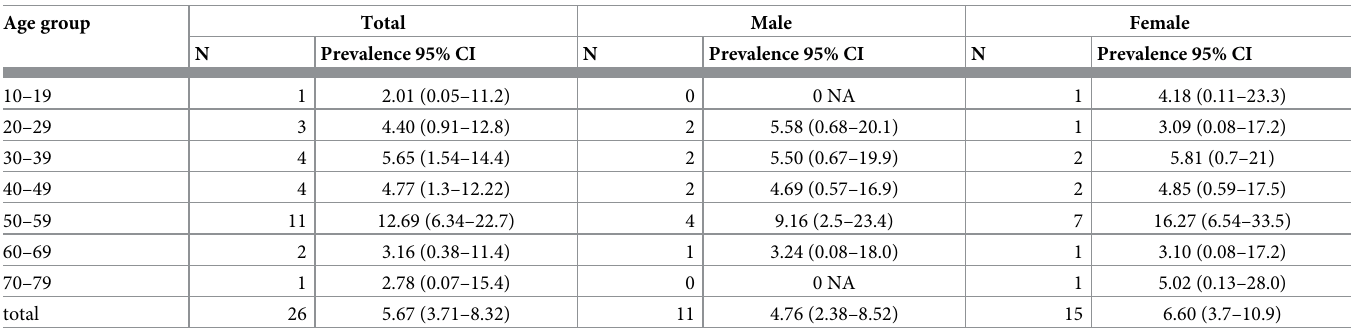
Table 1. The number of BHD patients according to age group and